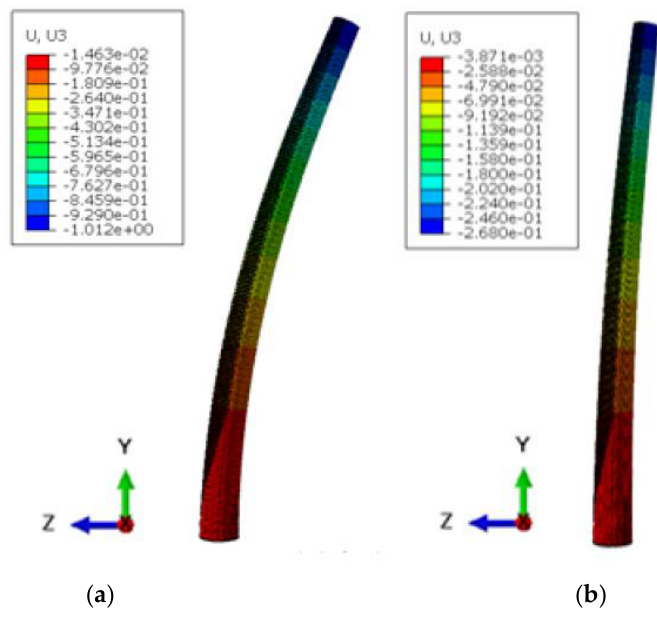
Figure 18. Lateral displacement: ( a ) Extreme sea state, ( b ) Normal